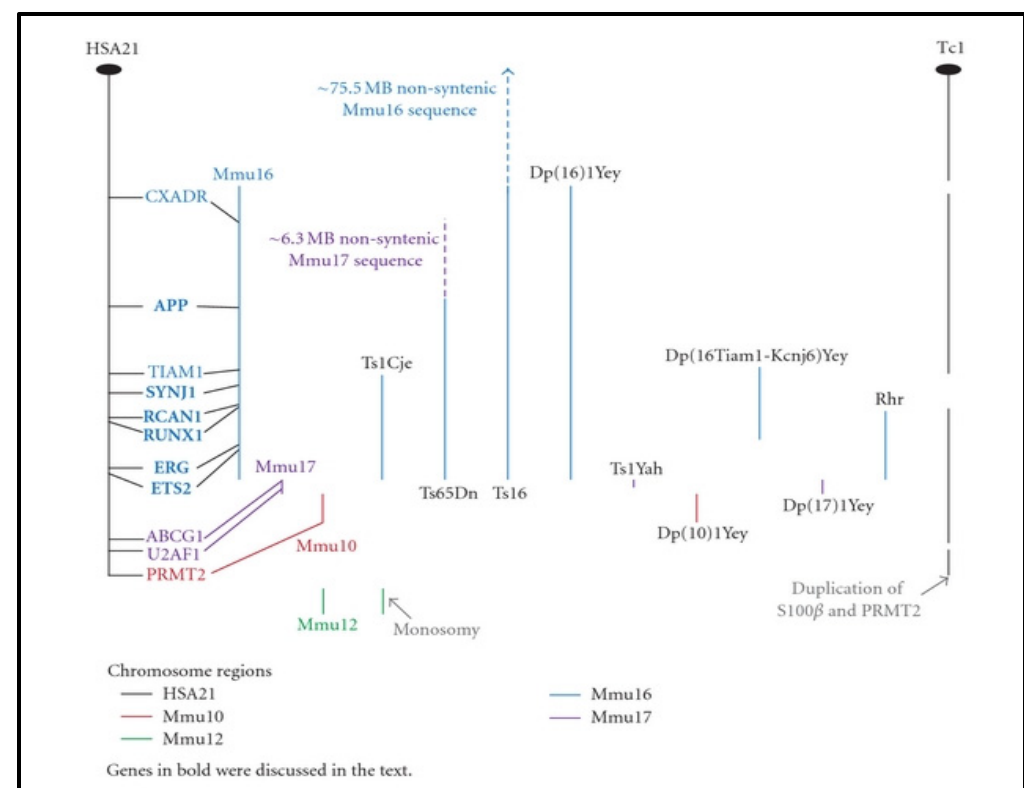
Figure 1. A graphical representation of HSA21 and the syntenic mouse chromosome regions from Mmu10, Mmu16, and Mmu17. The trisomic (or monosomic) chromosome regions present in 10 of the segmental mouse trisomies are also shown, with color-coding indicating the chromosome source of the region (see the key in the figure). The location of 11 HSA21 genes is shown, as well as their location on the syntenic chromosome regions, with text color indicating each syntenic chromosome. The dark ovals indicate the HSA21 centromere. (Figure 1 and legend adapted from [181].)